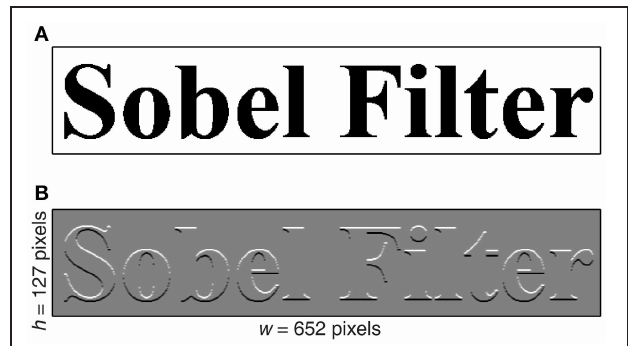
FIGURE 3 | Effect of Sobel filtering on the image. (A) An image containing the text “Sobel Filter” is displayed. (B) Same image after two-dimensional convolution with a 3 × 3 vertical Sobel operator (Equation 6). Note the enhancement of edge features with horizontal components and disappearance of edge features with vertical components.